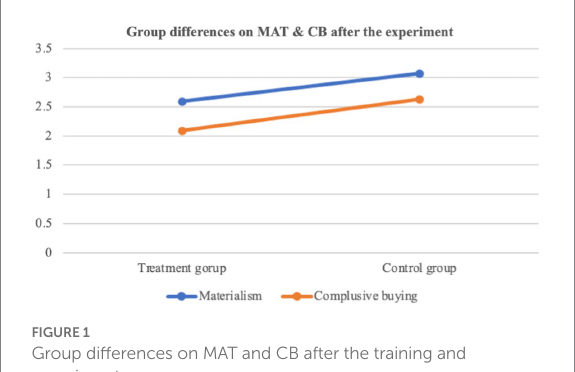
FIGURE 1 Group differences on MAT and CB after the training and